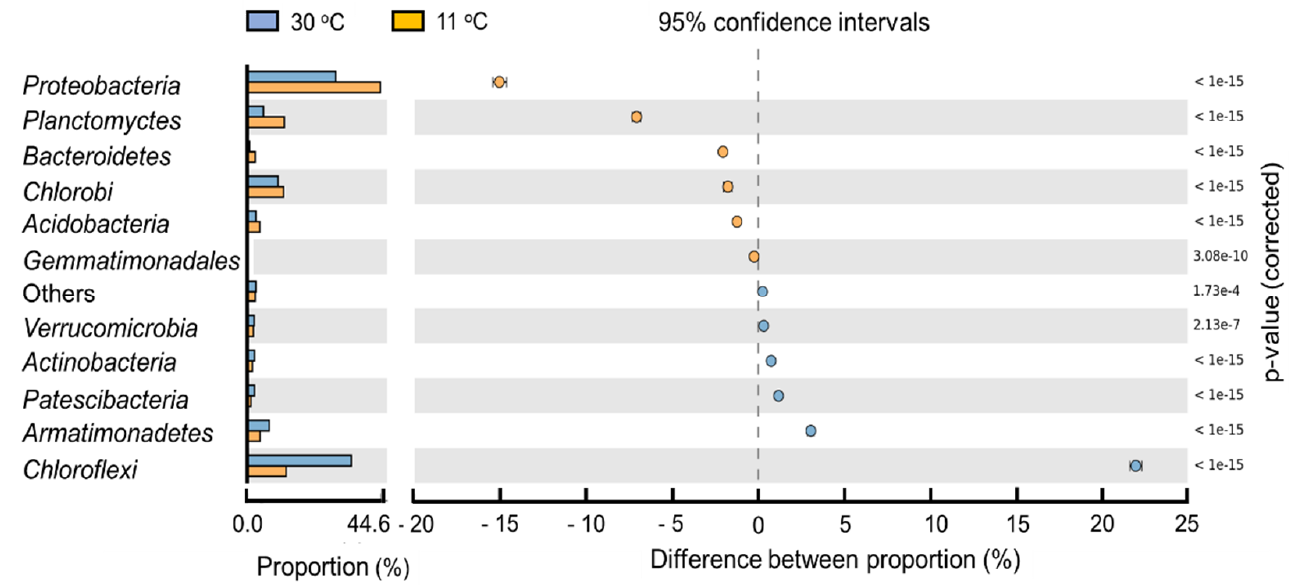
Figure 8. Statistical differences at 95% confidence intervals of the bacterial phyla abundances in the initial (at 30 °C blue) and terminal samples (at 11 °C orange).